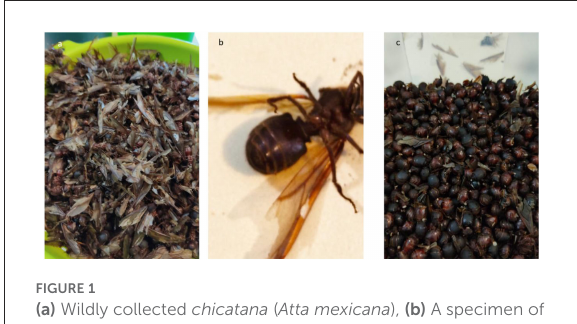
FIGURE1 (a) Wildly collected chicatana ( Atta mexicana ), (b) A specimen of Atta mexicana , (c) Chicatana prepared for cooking from Jalcomulco-Huatusco region (Veracruz, Mexico). Source: Authors own pictures. FIGURE2